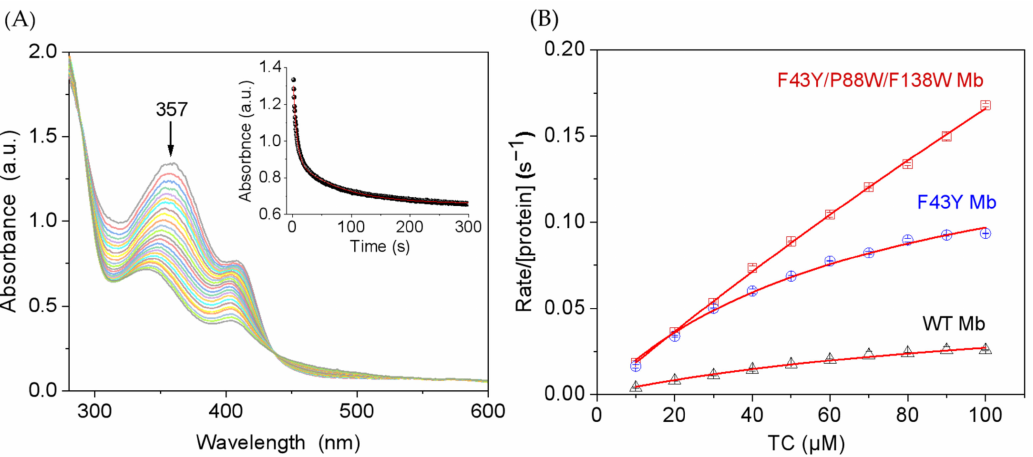
Figure 3. ( A ) Kinetic study of TC (100 µ M) oxidation in the presence of H 2 O 2 (0.4 mM) catalyzed by F43Y/P88W/F138W Mb (5 µ M). Time-dependent change of the absorbance at 357 nm was shown as inset and was fitted to the double-exponential decay function. ( B ) Steady-state rates of H 2 O 2 - dependent oxidation of TC catalyzed by F43Y/F138W/P88W Mb, F43Y Mb, and WT Mb, with increasing substrate concentrations. Reaction conditions: 5 µ M protein, 400 µ M H 2 O 2 , 25 mM potassium phosphate buffer, pH 7.0, 25 ◦ C. The data were fitted to the Michaelis-Menten equation. The error bar was generated by three triplicate